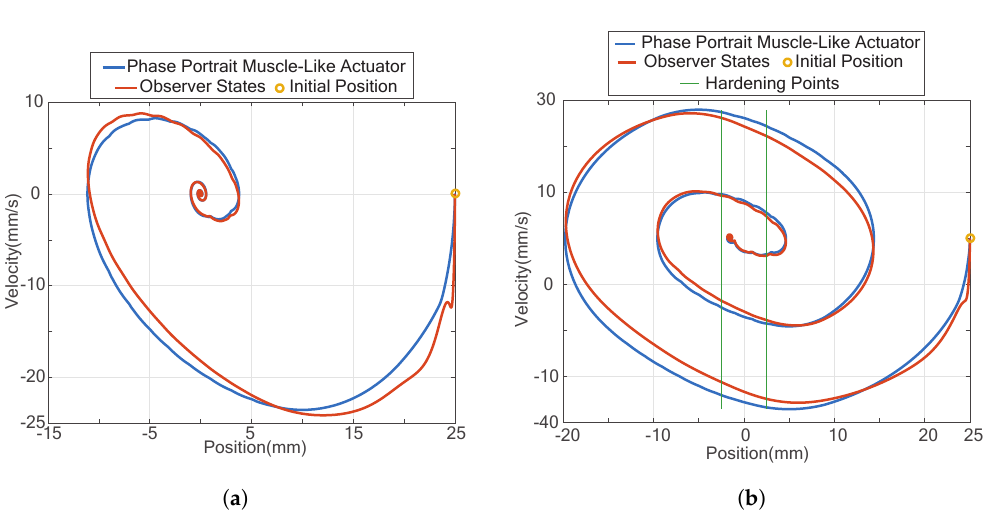
Figure 15. Antagonist control phase portraits: ( a ) antagonistic control with observer; and ( b ) antagonistic control with observer and disturbance